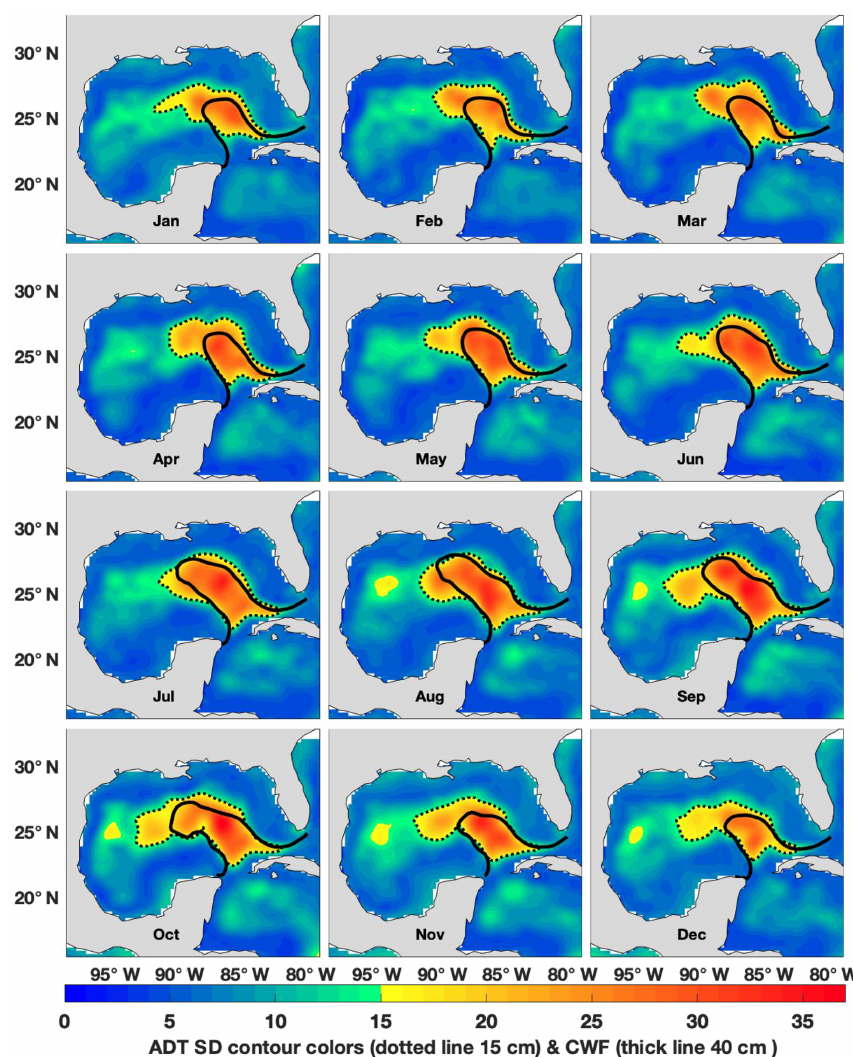
Figure 4. The ADT quarter-century CWF (1993–2017) monthly climatology and its standard deviation are shown in heavy and dotted lines, respectively. The heavy line corresponds to the 40cm isoline of the CWF. The dotted line encloses values of the standard deviation